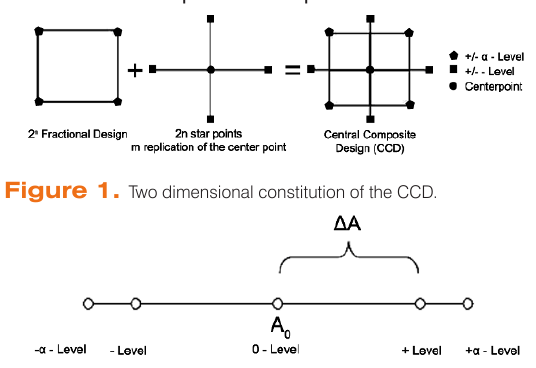
Figure 2. Schematically exposition of 5